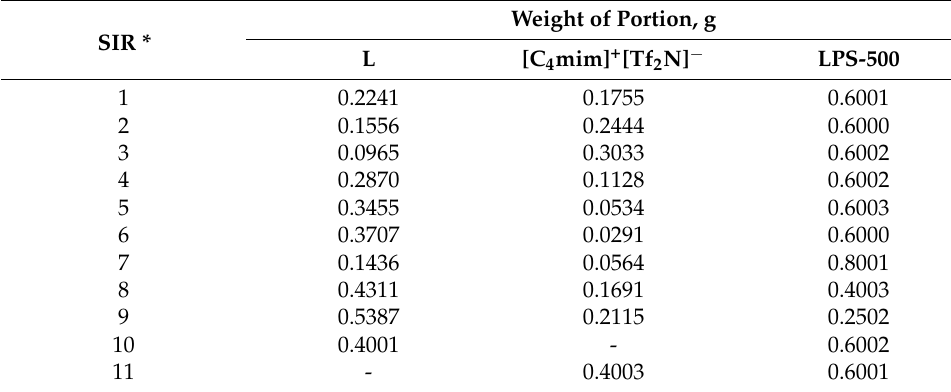
Table 6. Weighed portions of substances used to prepare SIRs *.